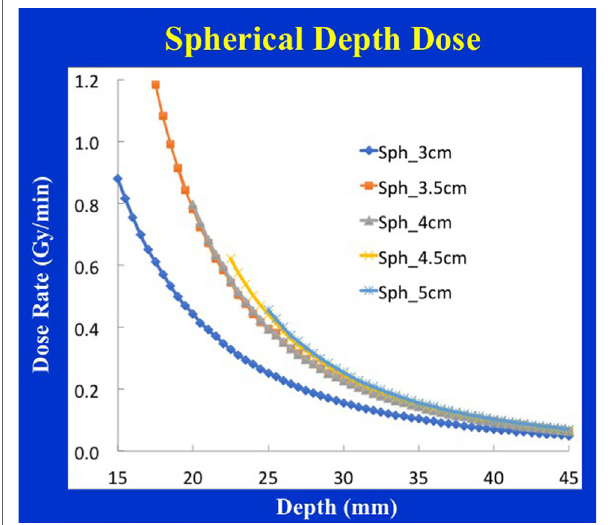
FigUre 5 | Spherical applicator depth-dose (DD) profiles for a range of diameters (3–5 cm) plotted as a function of the distance from the X-ray source. Note that each depth dose profile begins at the applicator surface, for example, DD profile for the 3 cm applicator begins at 1.5 cm from the